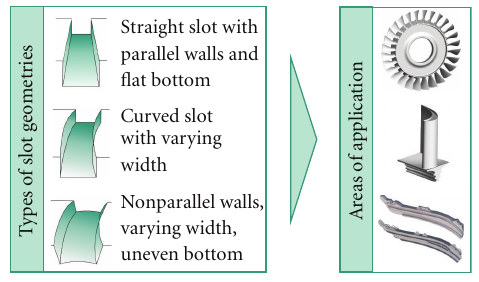
Figure 1: Areas of